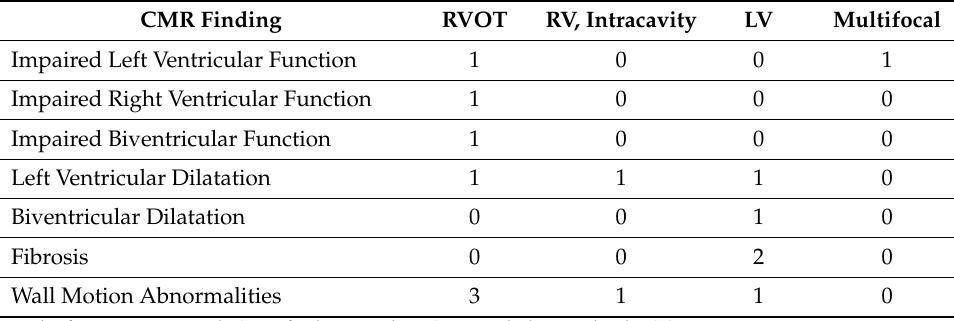
Table 4. Prevalence of CMR findings in relation to site of origin of PVCs. Origin of PVCs Patients with Pathology at CMR Patients with Normal CMR RVOT 5 11 RV, Intracavity 2 5 4 11 Multifocal 1 3 Data from 42 patients with PVCs recorded on 12-lead ECG. Table 5. Site of origin of PVCs in relation to findings at CMR.